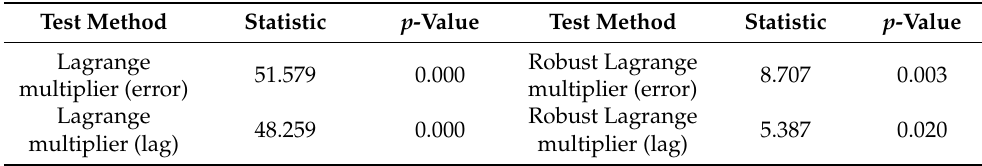
Table 5. Results of Lagrange multiplier (LM) test.